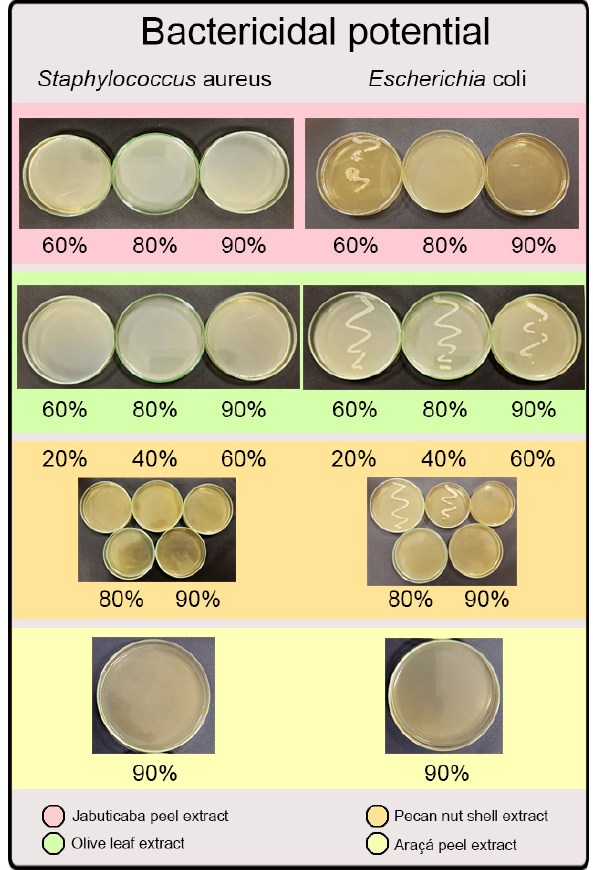
Figure 1. The bactericidal potential of the natural extracts against microorganisms Escherichia coli and Staphylococcus aureus . Through the inhibition analysis (Table 5), the minimum inhibitory concentration